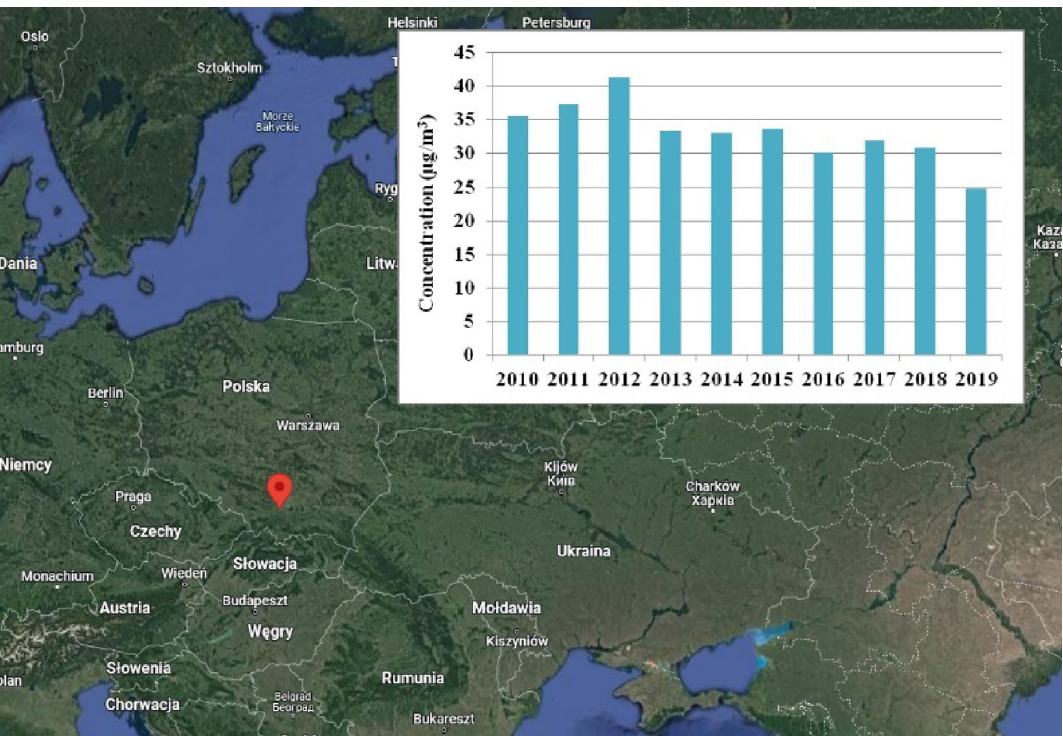
Figure 1. The Map with localization of sampling site in Krakow taken from Google maps and the annual average